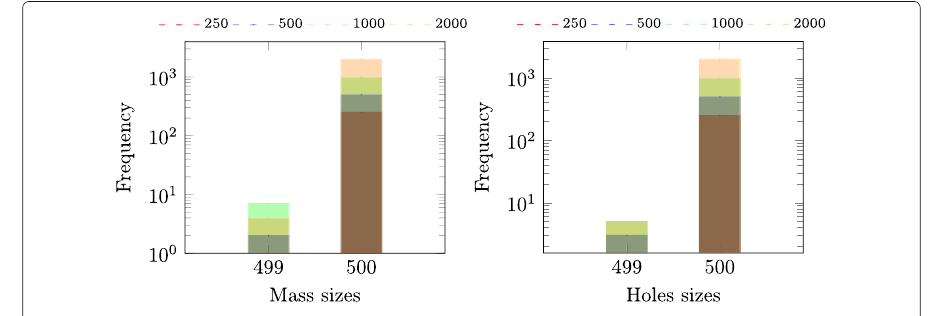
Fig. 6 Distribution of mass and hole